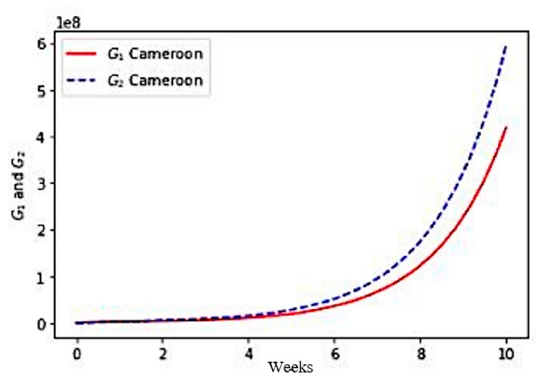
Figure 8. Numerical simulation of the variables I 1 and I 2 , R 1 and R 2 , G 1 , G 2 for Cameroon.